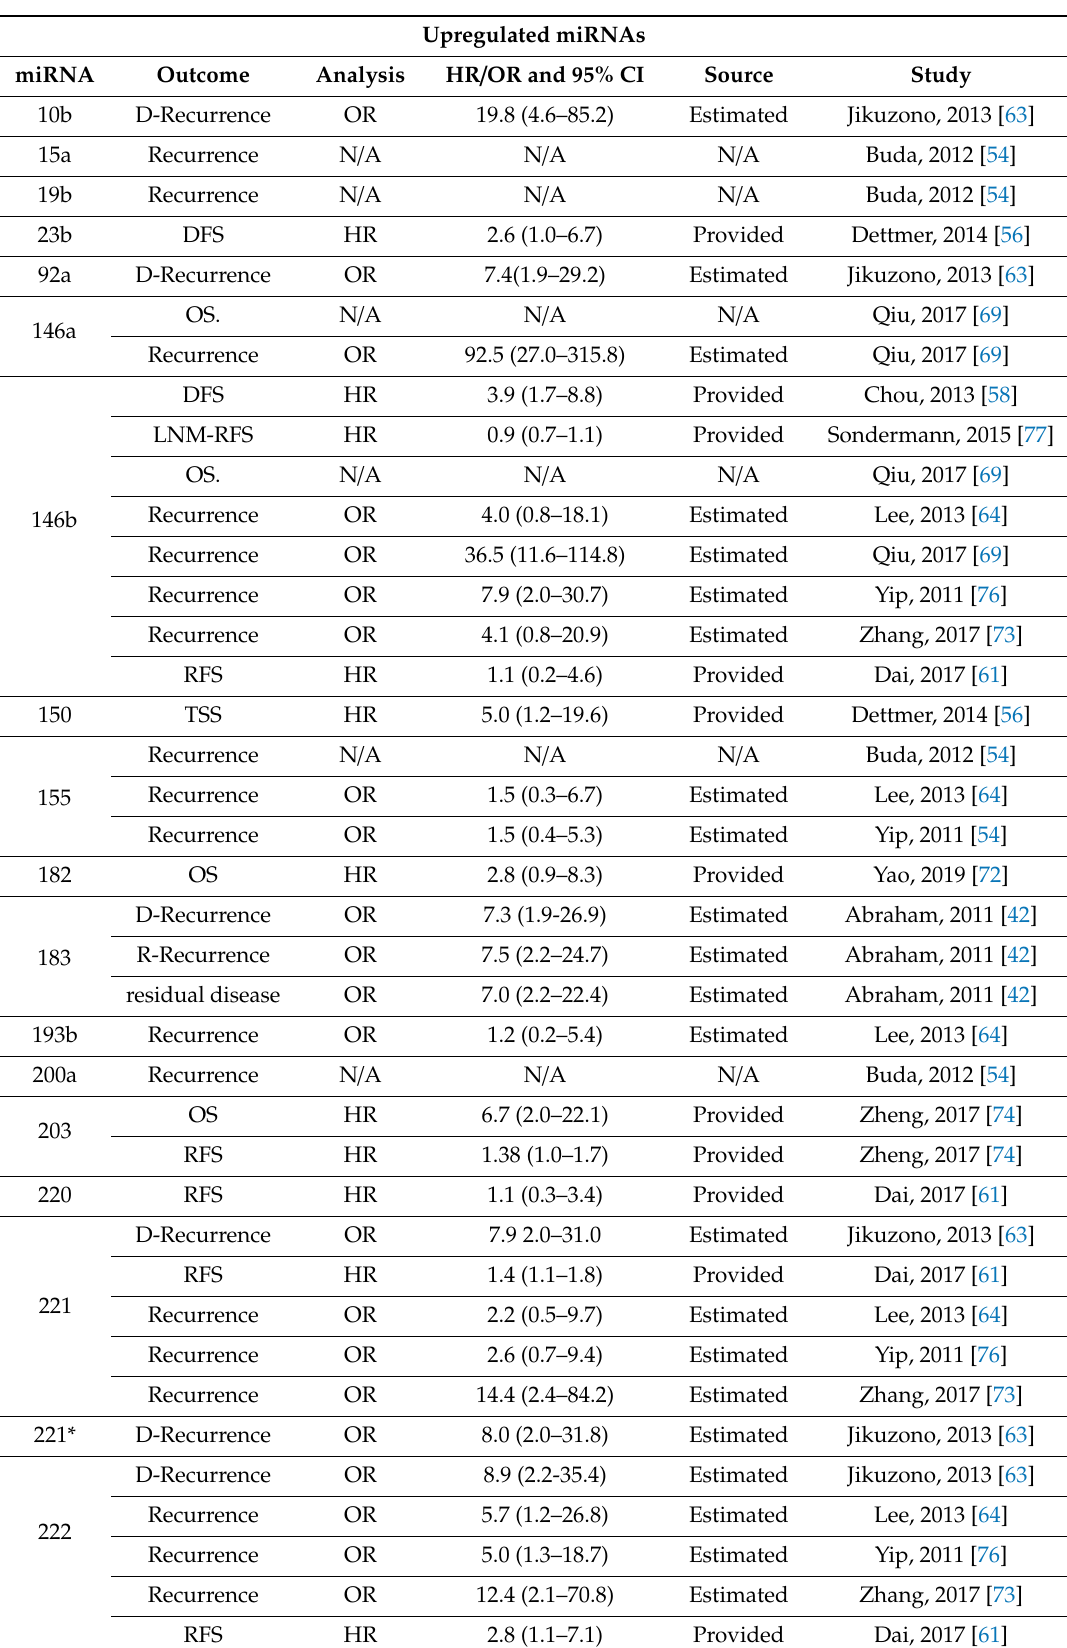
Table 2. Characteristics of the upregulated